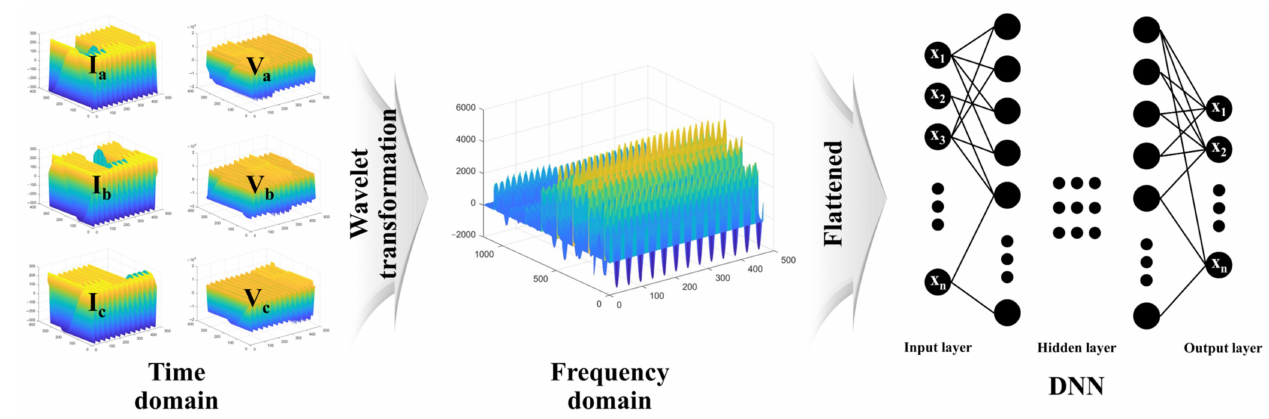
Figure 4. DNN training process of the proposed